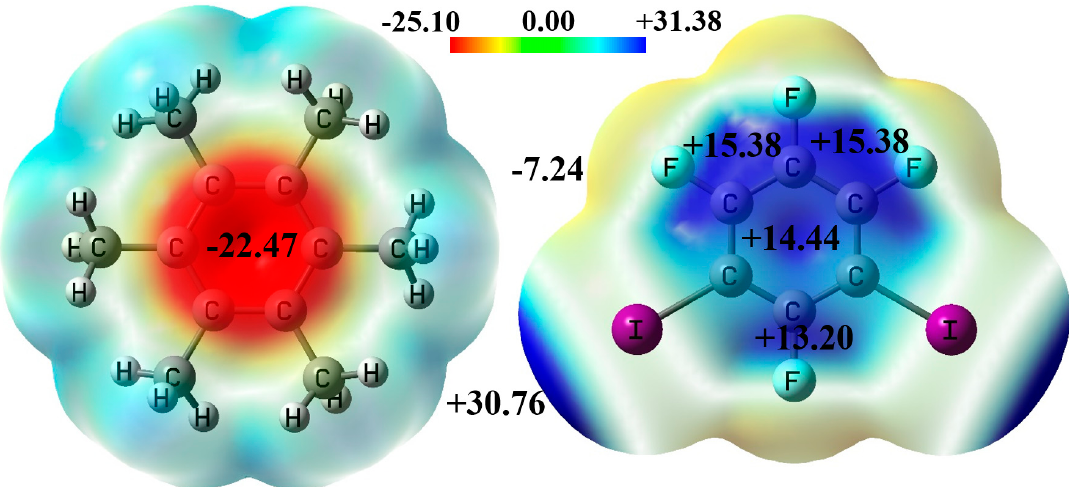
Figure 1. The molecular electrostatic potentials on the 0.001 a.u. electron density isodensity surfaces of hexamethylbenzene (HMB) (left) and 1,3-diiodotetrafluorobenzene (1,3-DITFB) (right). The numbers are in kcal/mol. Some selected surface minima and surface maxima are also shown.